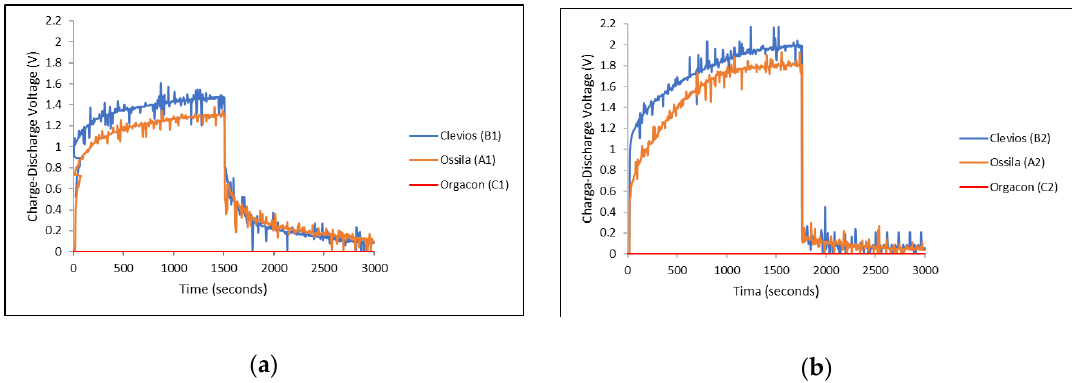
Figure 8. Charge-discharge characteristics of devices of different types of PEDOT:PSS with ( a ) SS/SS electrodes and ( b ) Ag-PBO/Ag-PBO electrodes, each charged at 3 V.